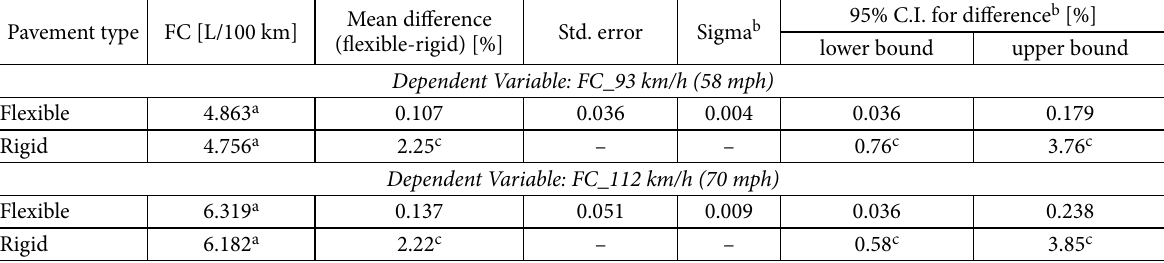
Table 3. Pairwise comparisons of analysis covariance